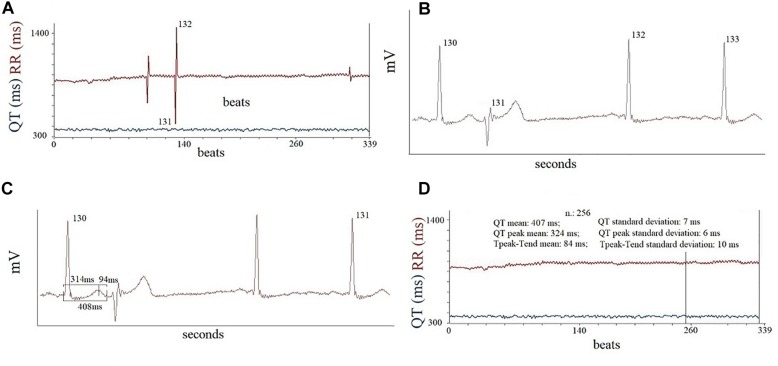
An example of RR and QTe recordings at rest (A), it is possible to observe three PVC in picture, the second PVC is the beat number 131. In the second phase of off-line analysis (B), the computer eliminated the data of PVC (131) and of following beats number 132. Note, the complete flattening of T wave of beat number 132. Therefore, this beats was eliminated from final analysis of data (C). Finally, it was reported the some final analyses in the 256 window data recordings (D).